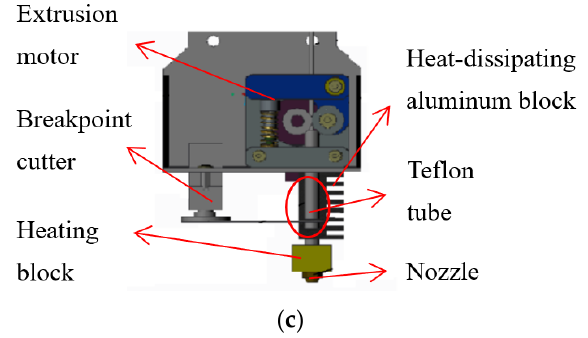
Figure 2. ( a ) Self-made 3D printer of CFRC. ( b ) Working principle of the printing heads. ( c ) Printing head of CFRF. Table 1. Machine parameters of the 3D printer.